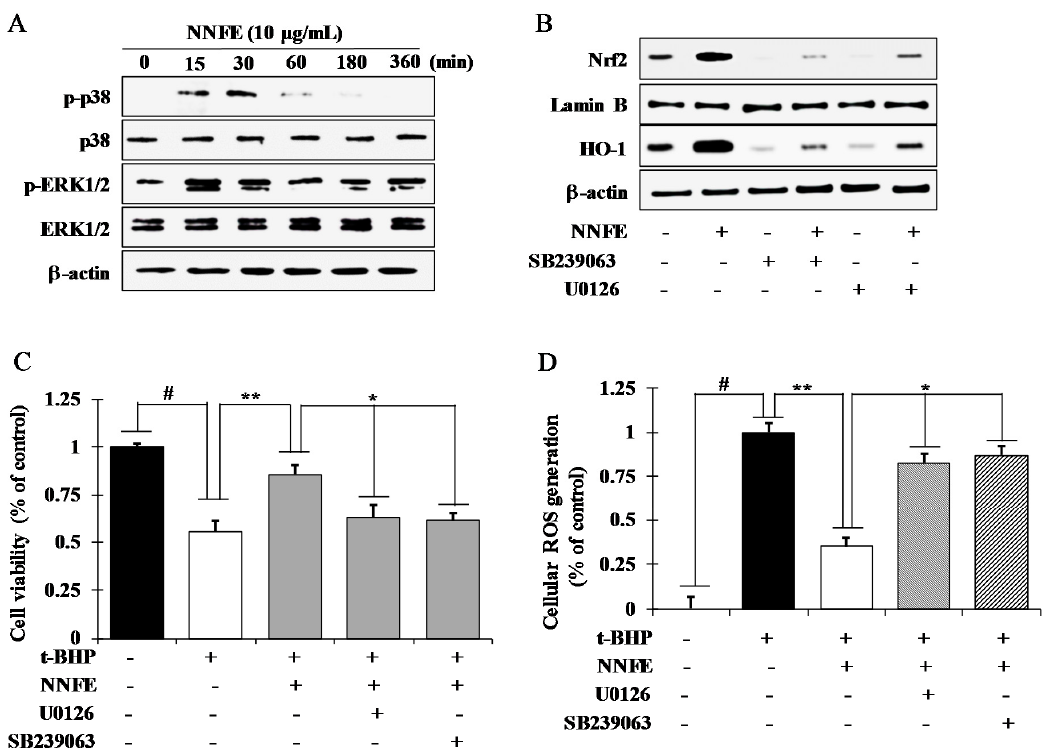
Figure 6. NNFE extract activates the translocation of Nrf2 by activating extracellular signal-regulated kinase 1 and 2 (ERK1/2) and p38. ( A ) RAW 264.7 cells were pretreated with 10 μ g/mL NNFE for the indicated time and kinase activation was analyzed by western blot. ( B ) Cells were treated with 10 μ g/mL NNFE in the presence and absence of specific inhibitor U0126 and SB239063 and the protein level of Nrf2 and HO-1 were analyzed by western blot. Following co-treatment with NNFE, U0126, and SB239063 for 12 h, cells were challenged with t -BHP for an additional 12 h, and then cell viability ( C ) and intracellular ROS generation ( D ) were analyzed. Statistical values are expressed as the mean ± SD ( n = 3). # p < 0.001 compared to no treatment, ** p < 0.01 compared to t -BHP treatment, * p < 0.05 compared to NNFE treatment. Statistical analysis was carried out using one-way ANOVA. ( − ): no treatment, (+): treatment with inhibitor and/or sample.